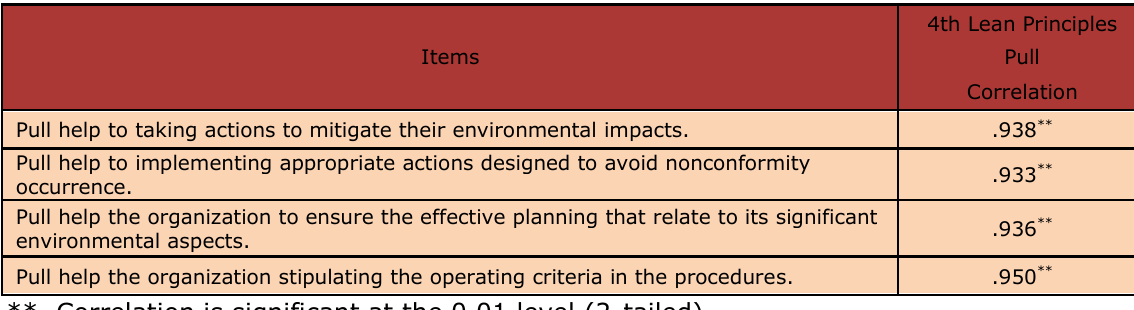
Table 9. Pull with ISO 14001